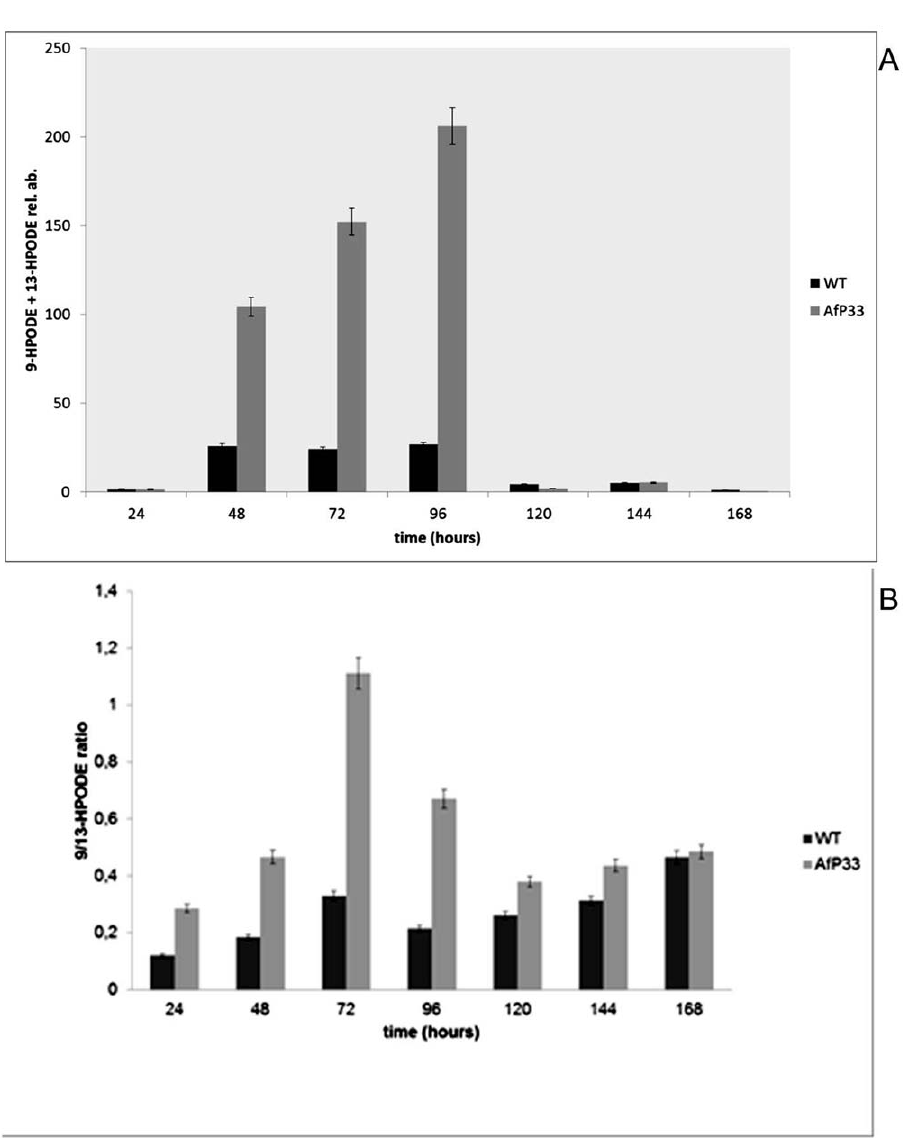
Figure 7. Generation of some oxylipins. (A) 9- and 13-HPODE (reported as relative abundance – rel. ab. – respect to the linoleic acid amount into the sample) and (B) 9- /13-HPODE ratio in mycelia of WT and AfP33 strains grown in CD (25 mL) and incubated at 30 u C from 24 to 168 hpi.